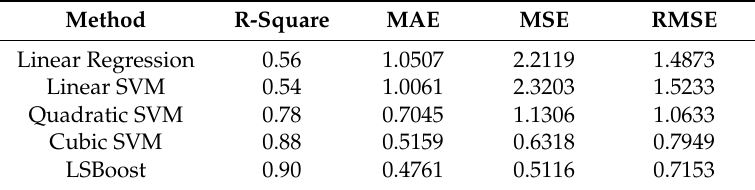
Table 5. Comparison of existing methods for the weekly forecast.